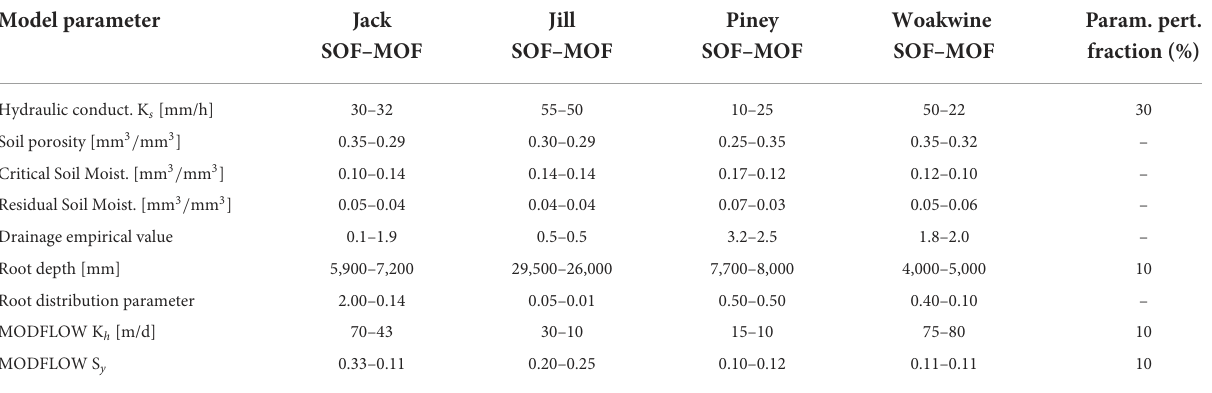
TABLE 2 Parameters and perturbation fractions used for the simulations. Model